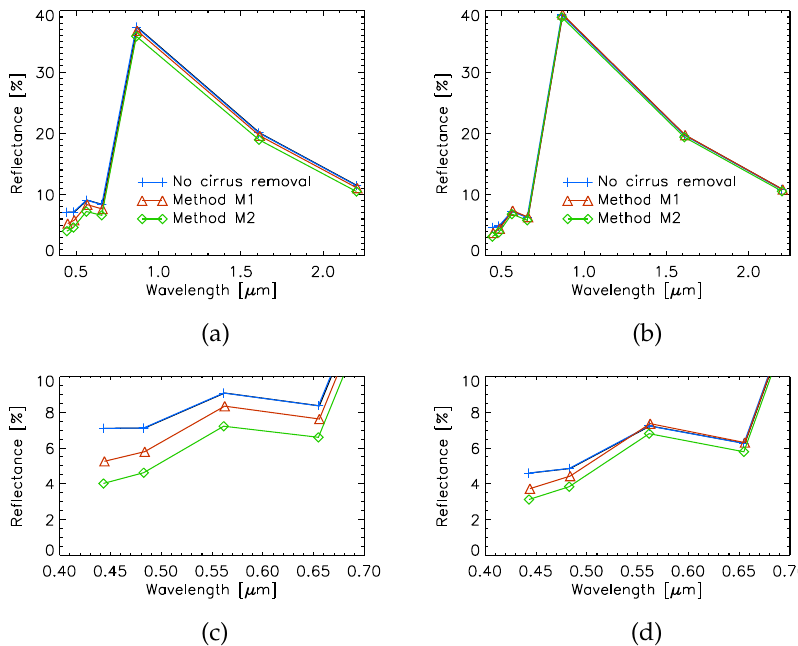
Figure 6. Surface reflectance spectra from cirrus region of Figure 5 ( a , c ) and from adjacent clear sky region ( b , d ) with no significant cirrus influence, using M1 and M2, respectively. Graphs ( c , d ): same spectra as ( a , b ), enlarged for the visible part of the